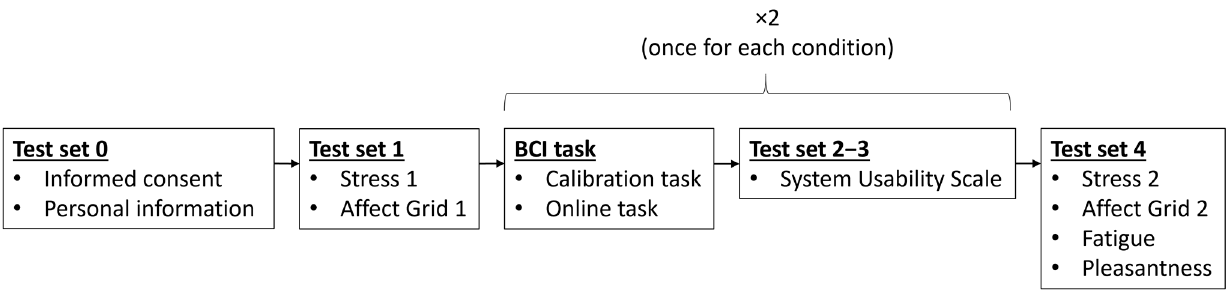
Figure 2. Sequence of questionnaires and tasks completed by each participant during the experi ‐ mental session.